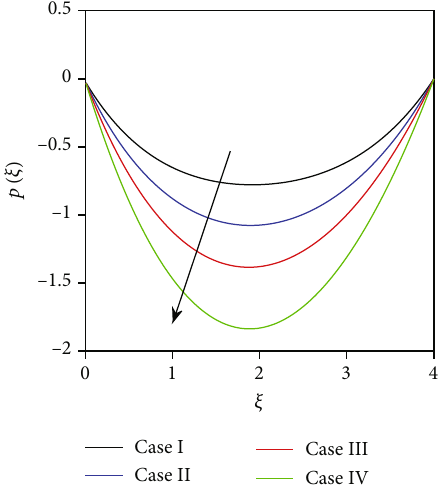
Figure 10: Tangential velocity pro fi les for micropolar material constants A 1 – A 6 .